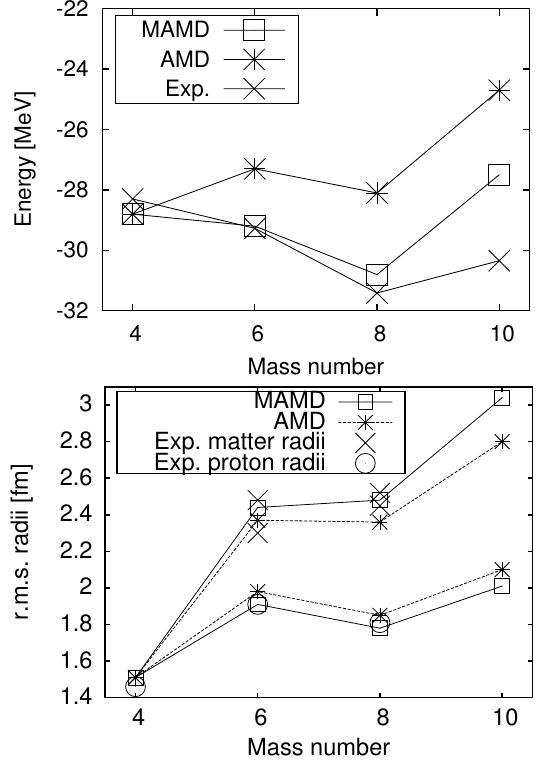
Fig. 1. Energies and radii of He isotopes. The experimental pro- ton radii are taken from Refs. [15–17], and the empirical values of the matter radii are taken from Refs. [18] and